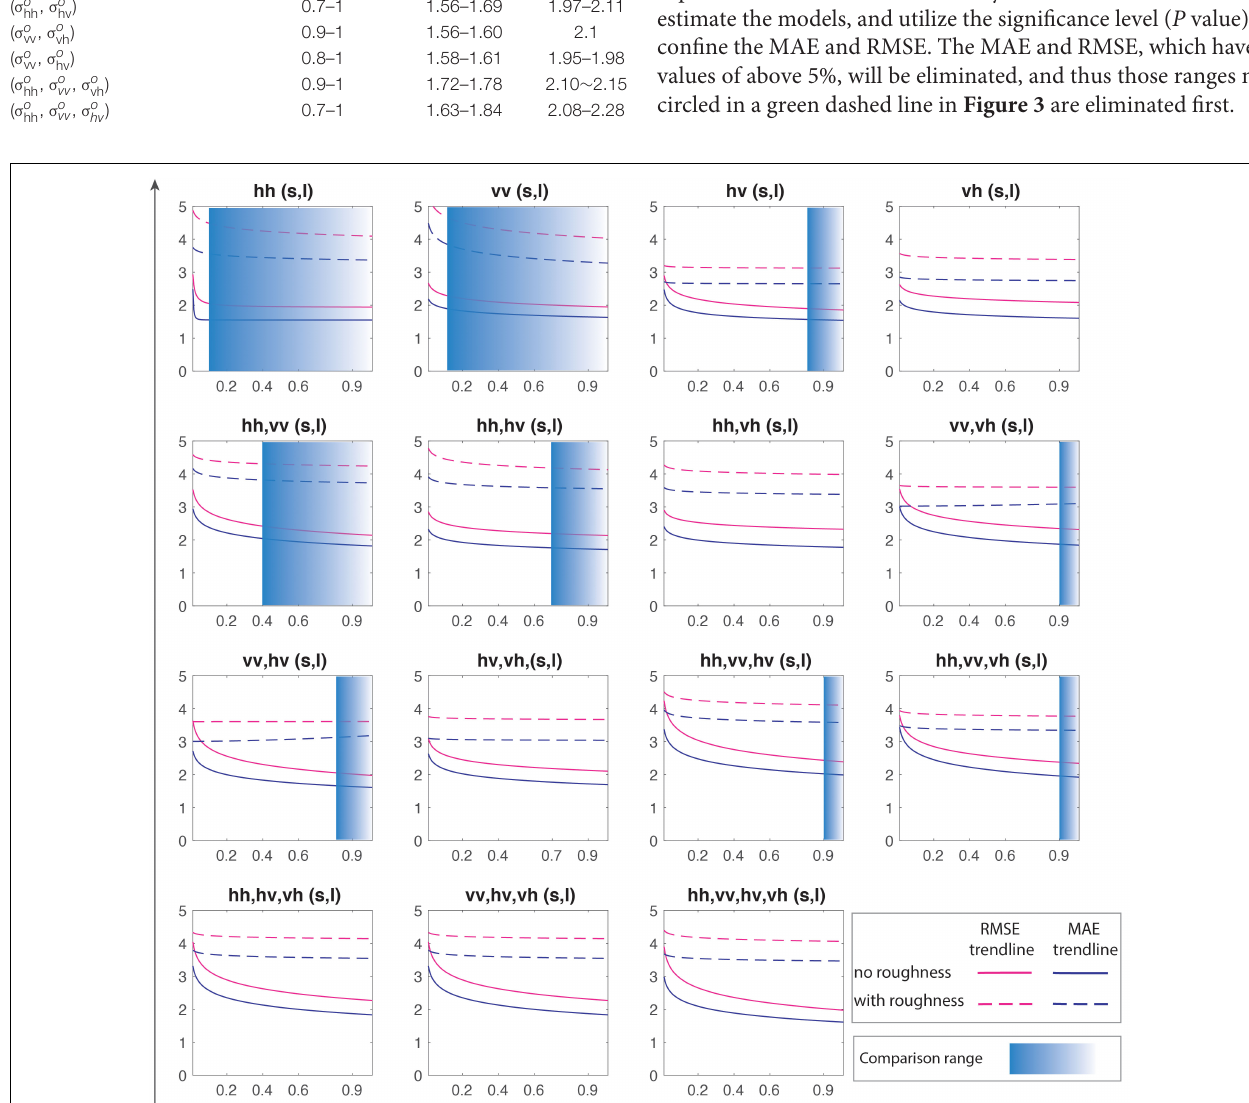
Frontiers in Earth Science |